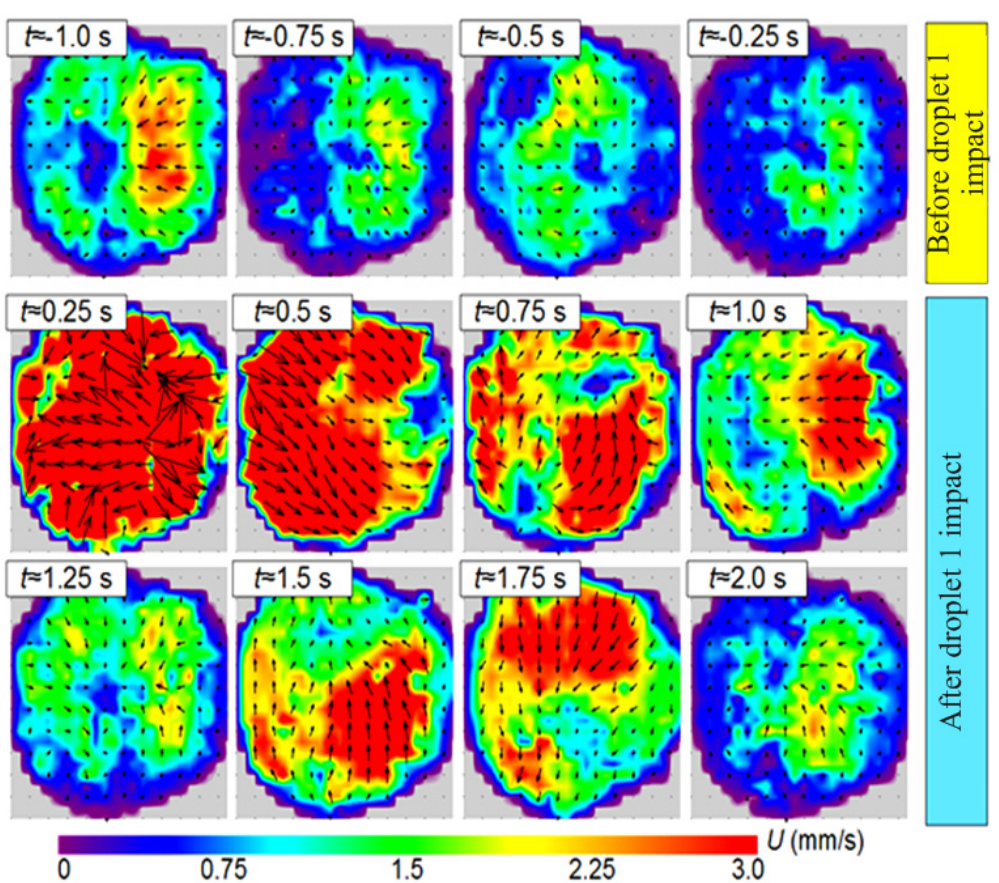
Figure 12. Velocity field in horizontal section of drop 2; V 01 = 2.5 μ l; V 02 = 40 μ l; T w = 80 °C; T 01 = 20 °C; water (drop 2), water + surfactant SDS (sodium dodecyl sulfate) (droplet 1).